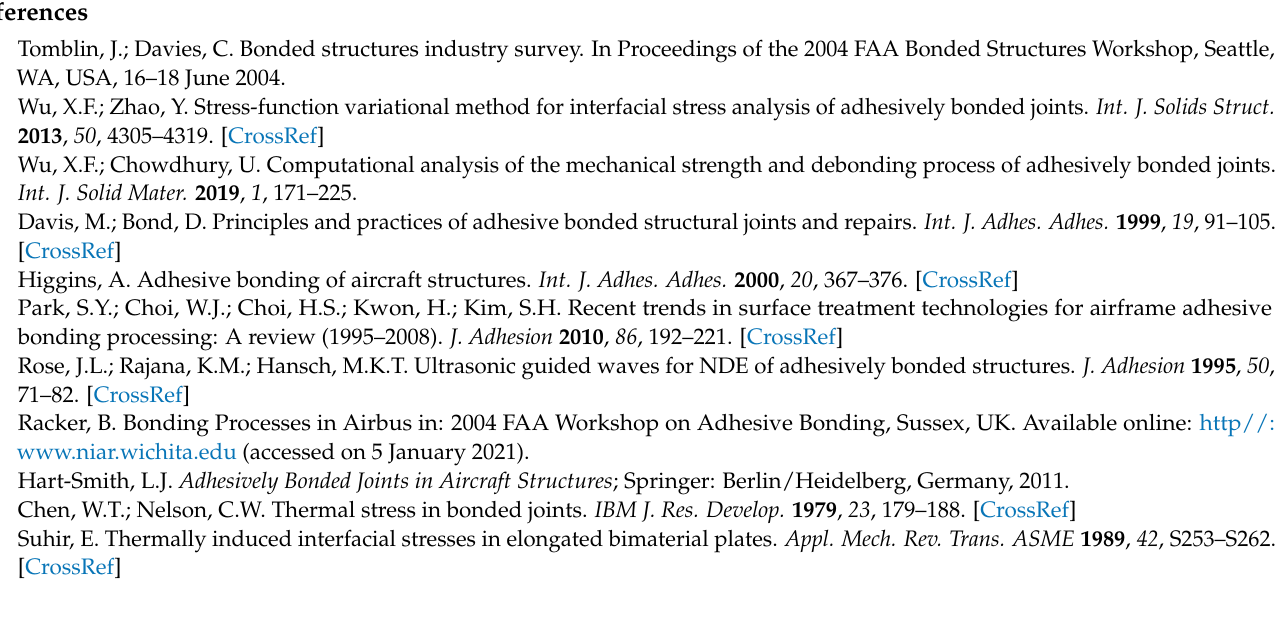
figure (3) plot(xx(kk),Syy_01, xx(kk), zero00(kk)); axis([ − 0.1, 8, − 40, 5]); xlabel(‘x/h2 (cid:48) ),ylabel(‘Normalized normal stress– g/p0 (cid:48) ); title(‘Predicted upper interfacial normal stresses–g/t0 (cid:48) ); figure (4) plot(xx(kk),Syy_02, xx(kk), zero00(kk)); axis([ − 0.1, 8, − 15, 20]); xlabel(‘x/h2 (cid:48) ),ylabel(‘Normalized normal stress– g/t0 (cid:48) ); title(‘Predicted lower interfacial normal stresses–g/t0 (cid:48)